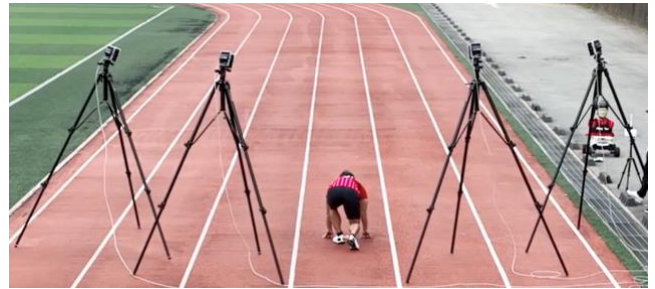
Figure 23. Vicon field tests at the campus